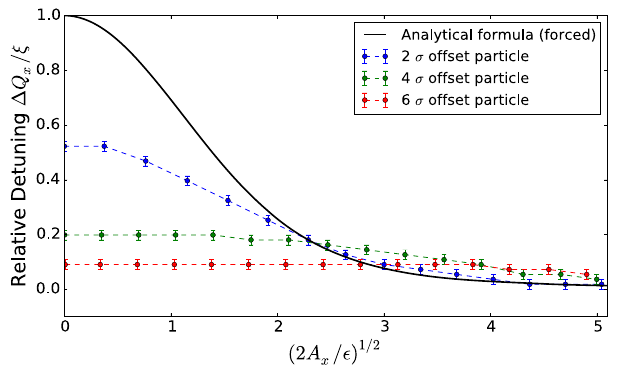
FIG. 5. Simulated frequency spectrograms for the horizontal (top) and vertical (bottom) planes versus horizontal amplitude of forced oscillations in the weakly interacting beam. The black curves correspond to the single particle forced beam-beam amplitude detuning analytical formulas in Eqs. (18) and Eq.